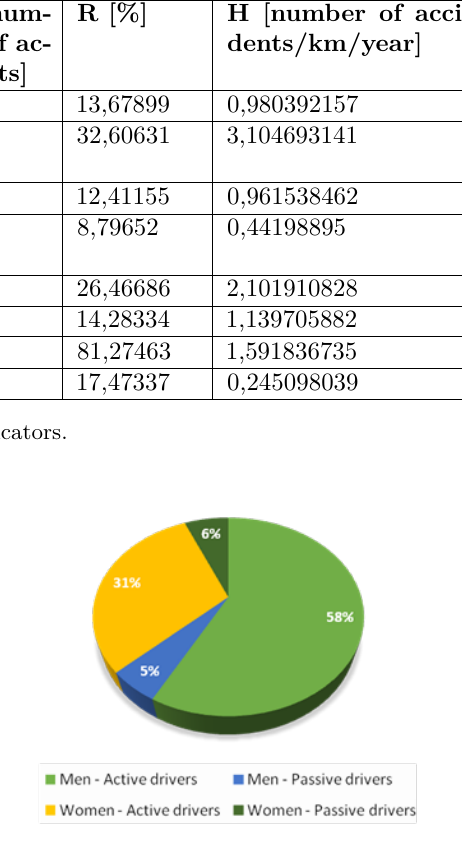
Figure 3. Percentage of active and passive